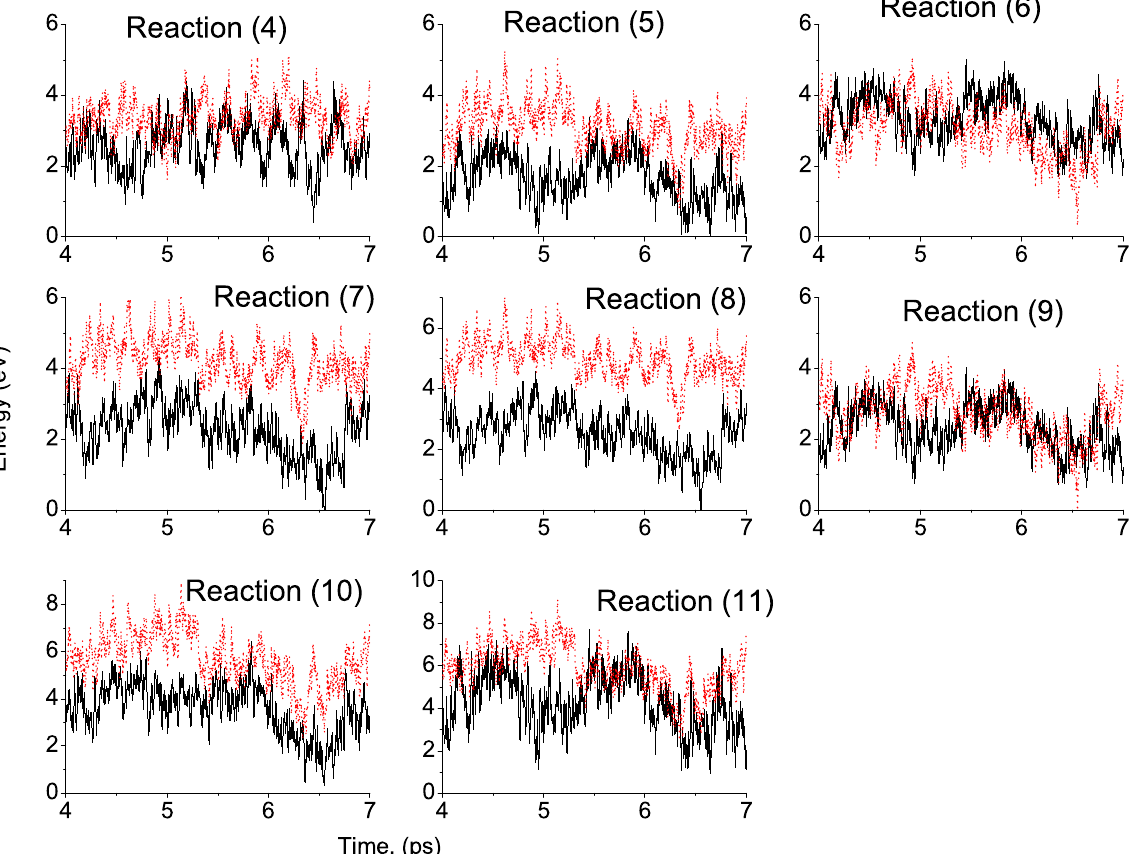
Figure 7. Total energy vs time of reactions (6) to (13). The solid lines (black) are the total energy of the left hand side of reactions (6) to (13) and the dotted lines (red) are the total energy of the right hand side of reactions (6) to (13). We chose zero energy as arbitrary.